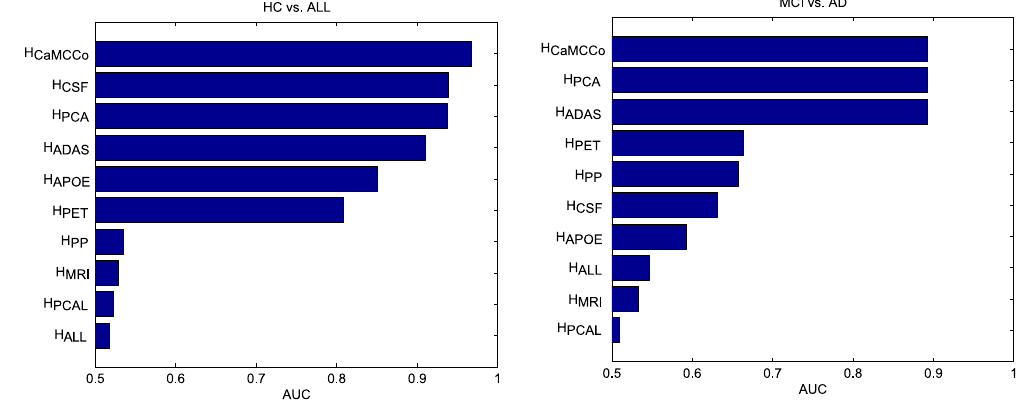
Figure 3. Performance of single and multi modality cascaded classifiers. Area under the ROC curve (AUC) for prediction of ( a ) healthy control (HC) from all cognitive impairments, and ( b ) mild cognitive impairment (MCI) from Alzheimer’s Disease (AD).